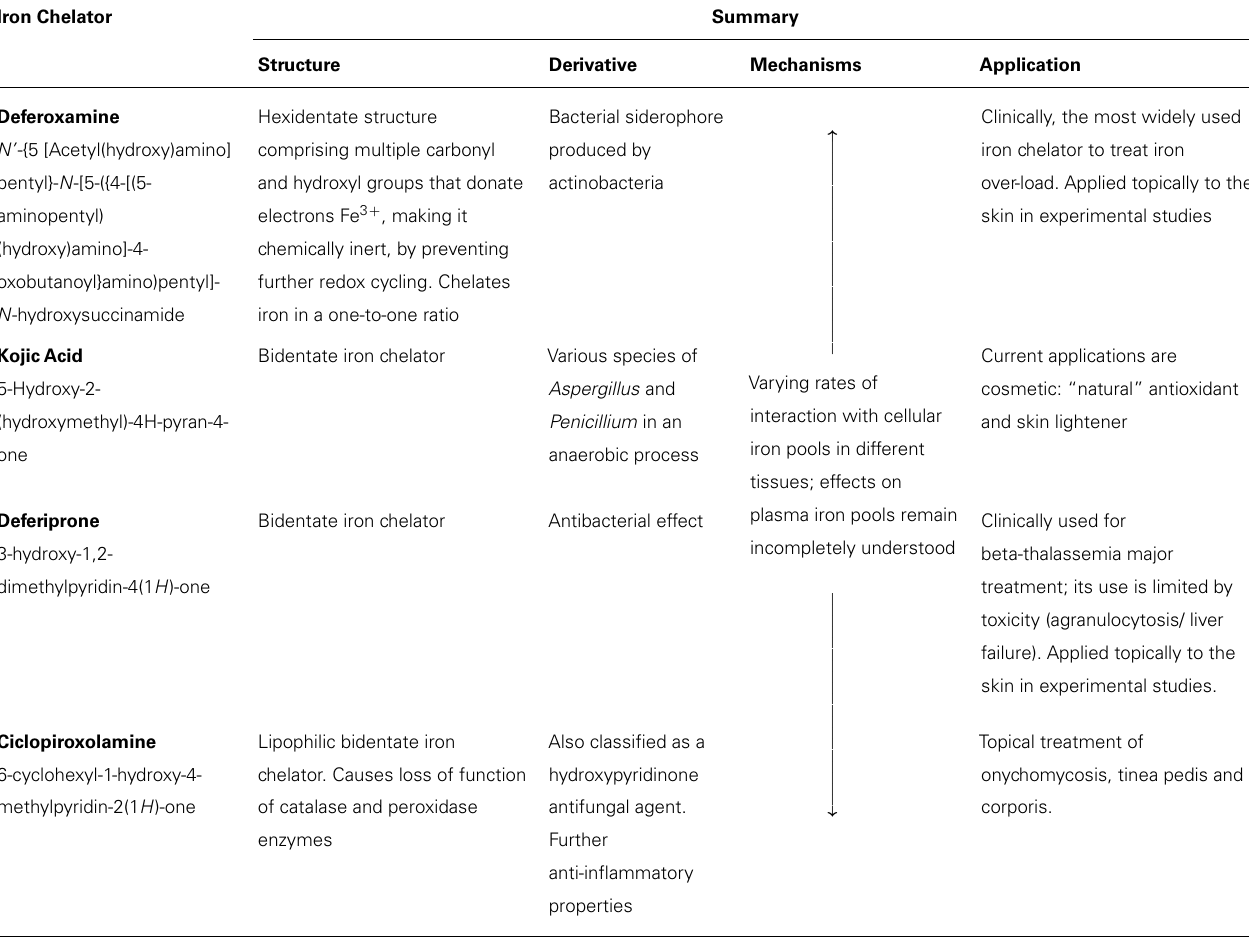
Table 1 | Summary of iron